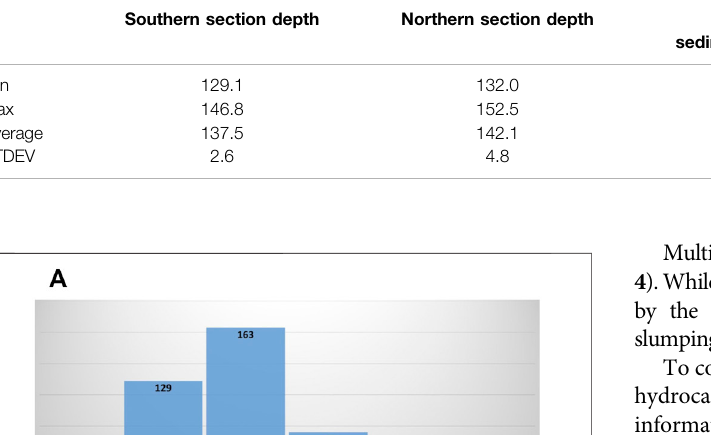
Frontiers in Earth Science |